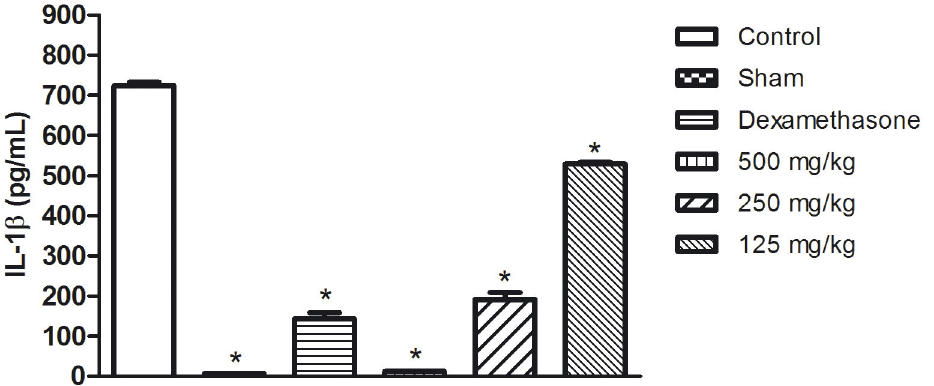
Figure 5. IL-1β (pg/mL) levels after the end of carrageenan-induced pleurisy assay in exudate of the pleural cavity of mice previously treated with aqueous seed extract. *p<0.05 in comparison with control by ANOVA followed by Newman-Keuls test.